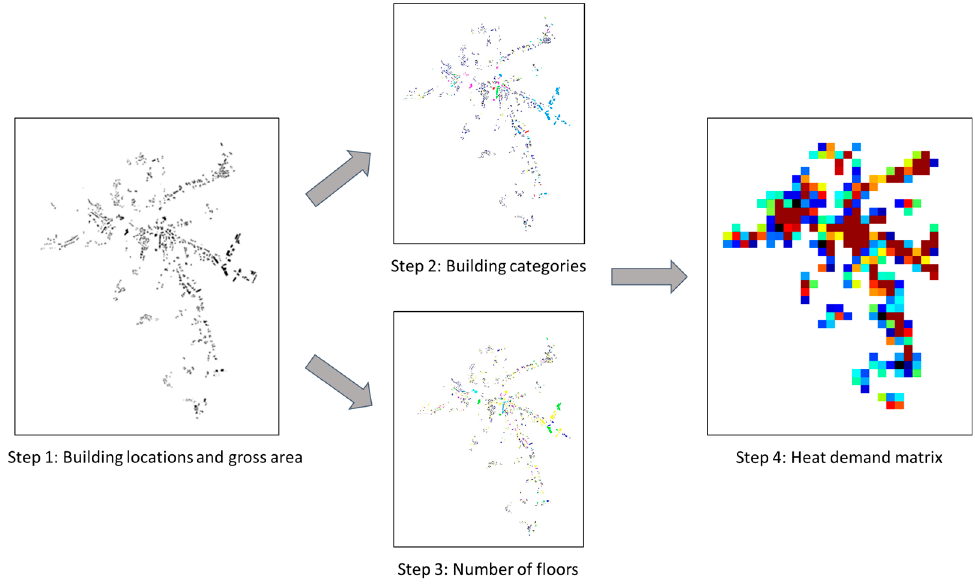
Figure 1. Graphical representation of the four main steps in the heat demand mapping method.